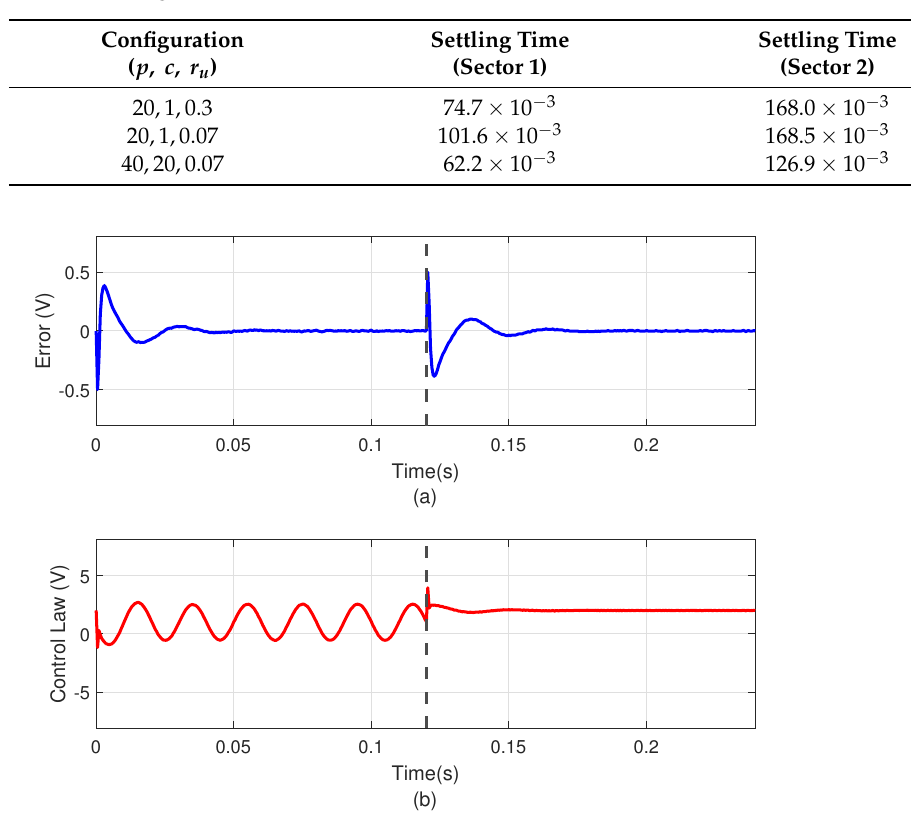
Figure 8. Experimental result for test 2, using p = 20, c = 1, r u = 0.3. ( a ) Error. ( b ) Control law.